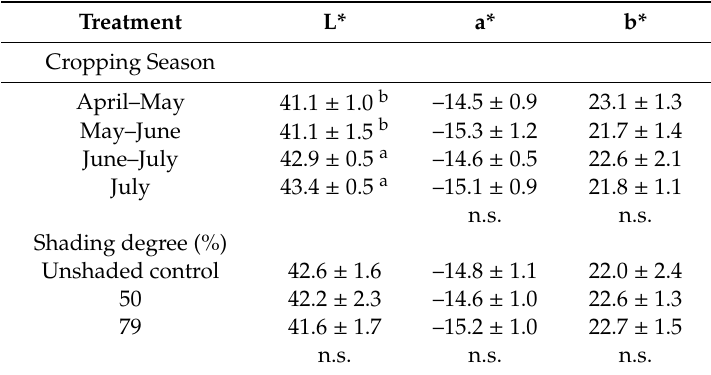
Table 2. Colorimetric parameters as a ff ected by cropping season and shading degree.